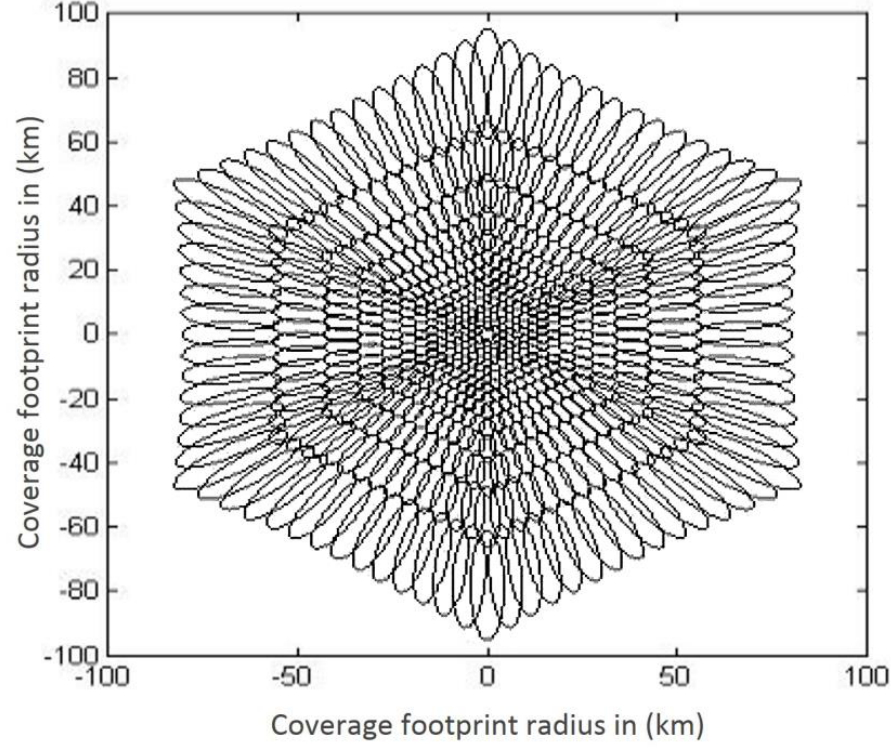
Figure 10. Optimized cellular structure layout for Riyadh.